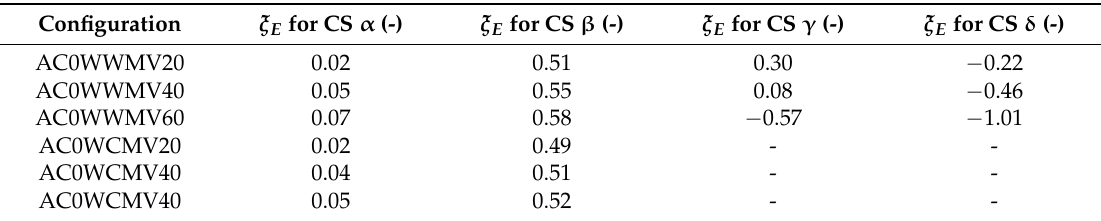
Table 7. Energy effectiveness coefficient of the two best air curtain configurations.